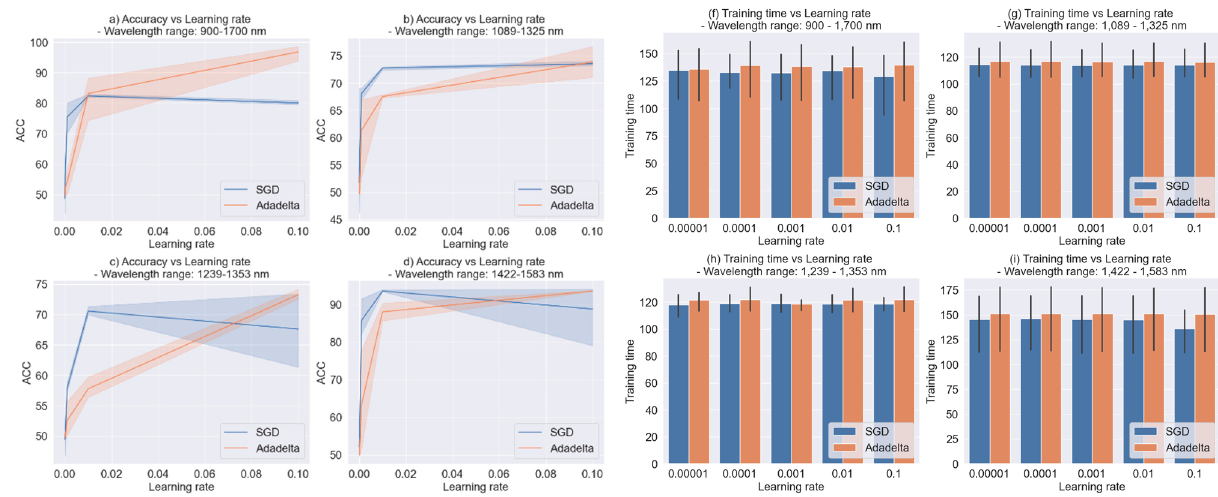
Figure 10. Accuracy and Training time vs. Learning rate.